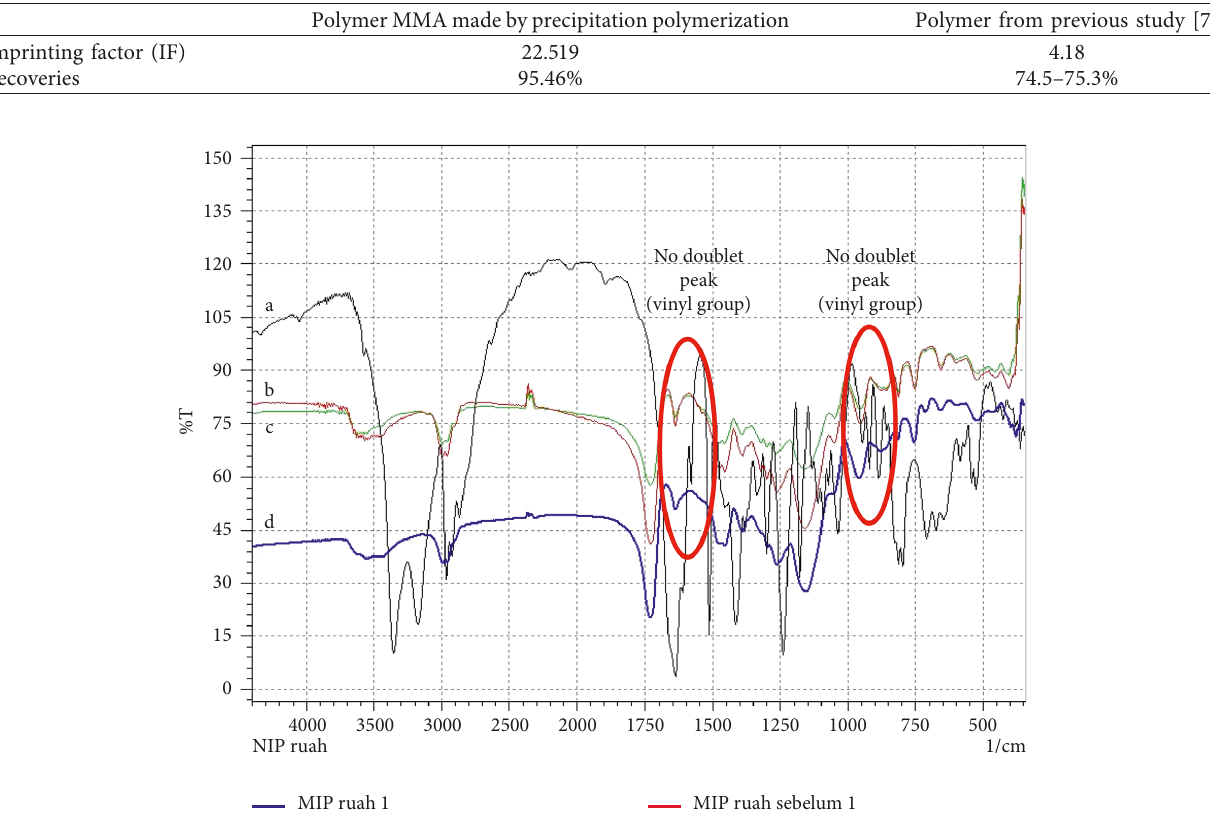
Table 4: Result of application of the polymer in serum samples compared to previous study [7].